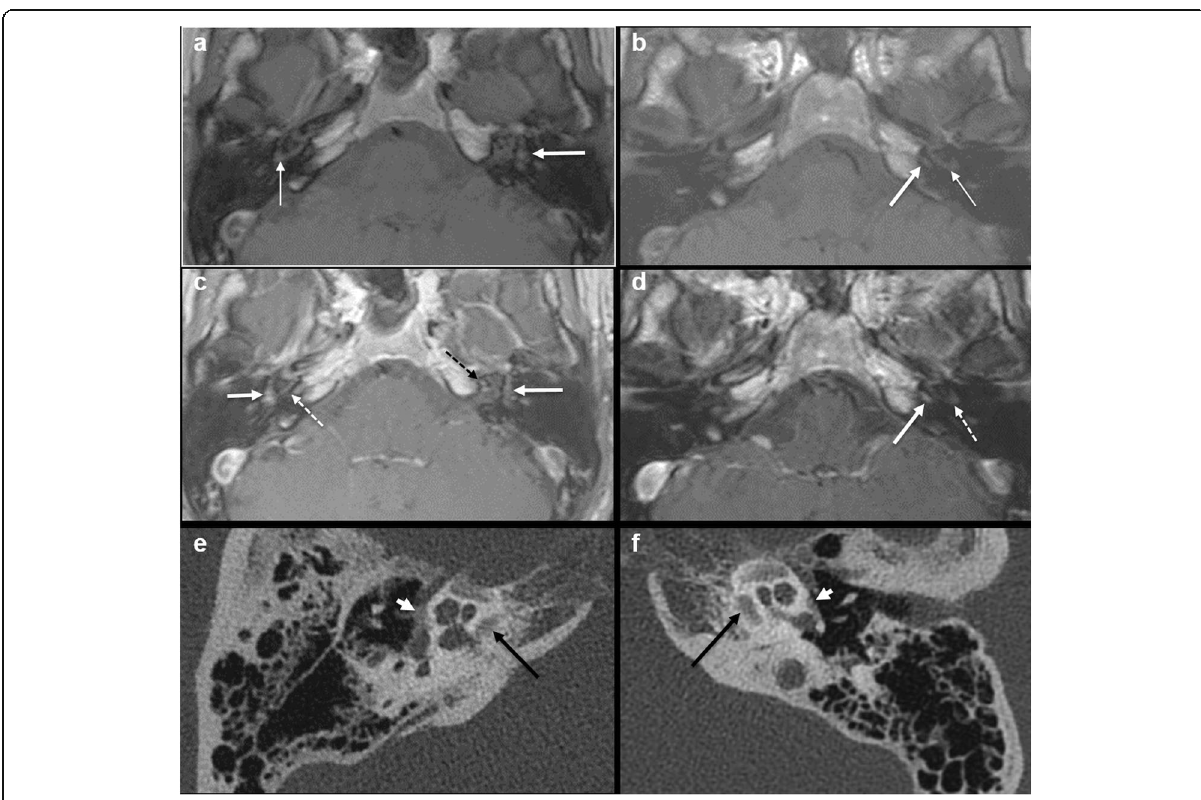
Fig. 3 A 46-year-old male patient with right-sided MHL (case 8). Axial T1W MR image ( a ) shows intermediate T1 signal around the basal turn of the right cochlea (thin arrow) and in the left FA region (thick arrow). Axial T1W MR image at a lower level ( b ) shows intermediate T1 signal around the basal turn of the left cochlea (thin arrow) and another separate focus of intermediate signal in the left pericochlear region (thick arrow). Contrast-enhanced axial T1W image ( c ) shows moderate post-contrast enhancement in bilateral FA regions (arrows) and mild enhancement around the basal turns of cochleae (dashed arrows). Contrast-enhanced axial T1W image at a lower level ( d ) shows mild enhancement around the basal turn of left cochlea (dashed arrow) and another focus of enhancement in the left pericochlear region (arrow). Subsequent axial HRCT images ( e , f ) confirm bilateral fenestral otosclerotic plaques (short white arrows) and pericochlear plaques (black long